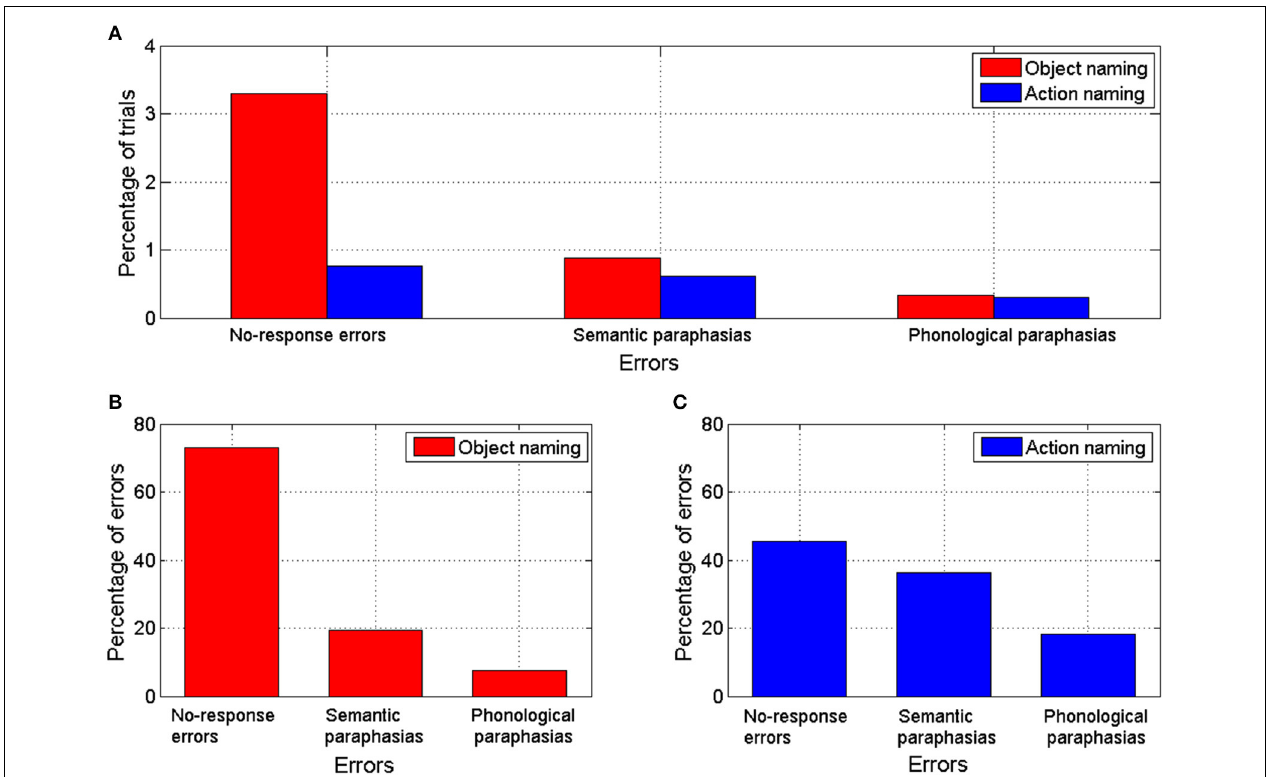
FIGURE 3 | (A) Percentage of trials with errors out of the total number of trials during nTMS for object and action naming tasks. (B) Percentage of errors of each error category out of the total number of naming errors